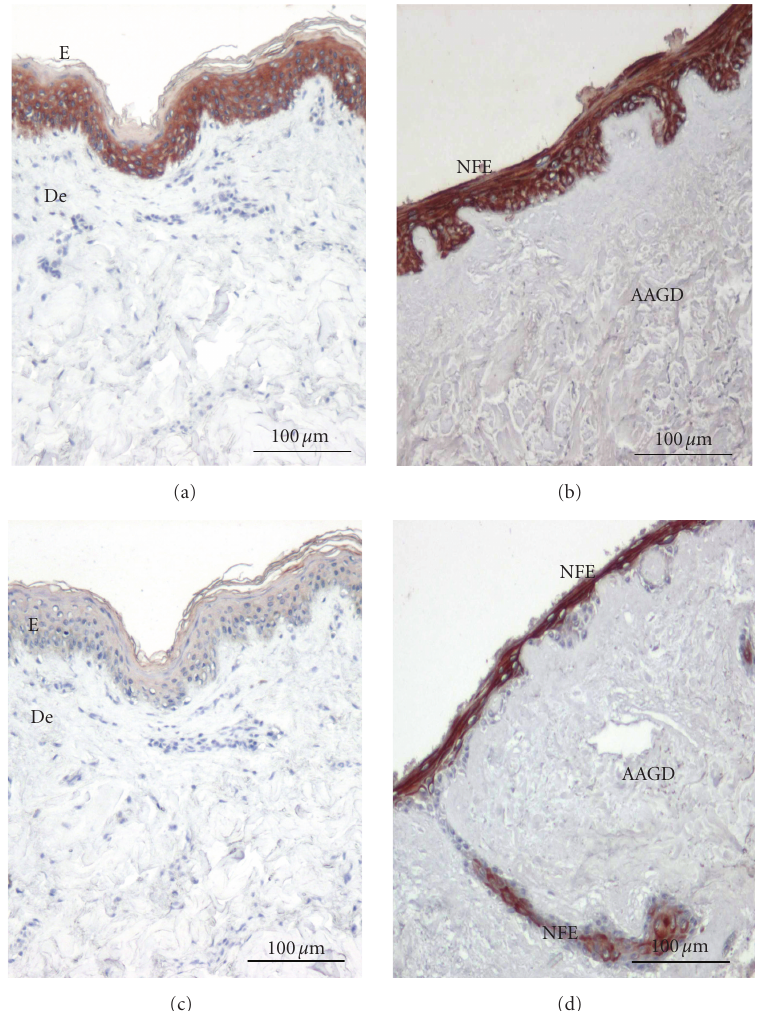
Figure 8: Immunohistochemical localization of human keratin in NS ((a) and (c)) and biosubstitute sections ((b) and (d)) at 14 days. ((a) and (b)): The sections were stained with cytokeratin AE1/AE3 Moab and ((c) and (d)) cytokeratin 16 Moab. Original magnification: 10x. E: epidermis, De: dermis, AAGD: alloplastic acellular glycerolized dermis, NFE: newly formed epithelium.